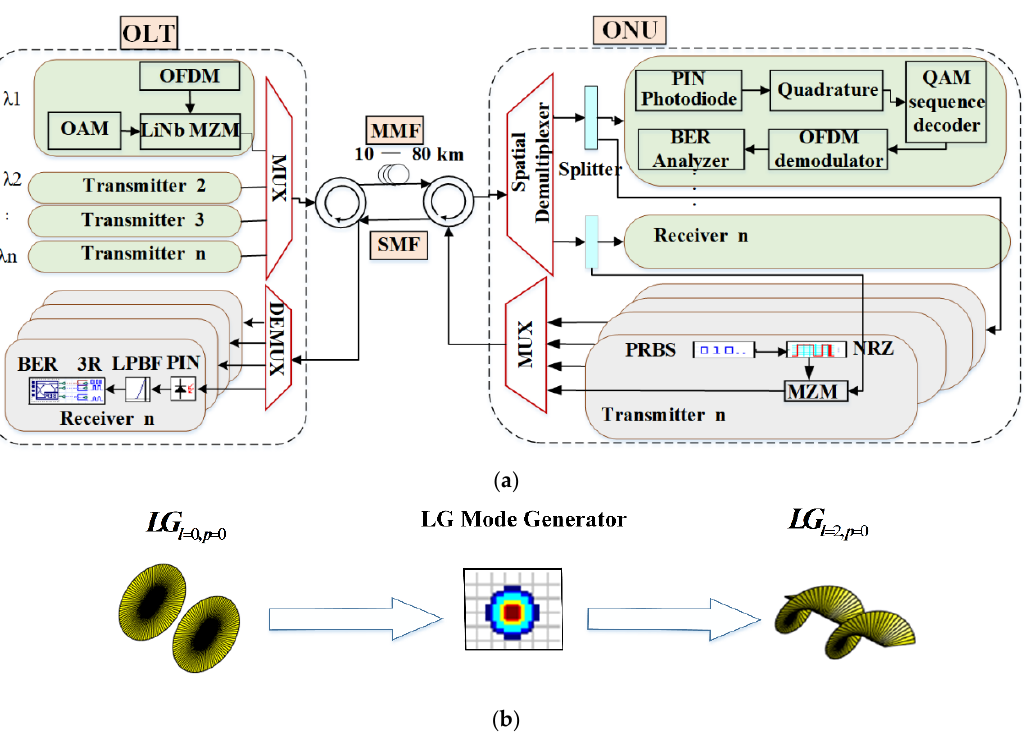
Figure 2. The schematic diagram of ( a ) the proposed OAM-DM-WDM-OFDM-PON system; ( b ) LG l = 2, p = 0 mode